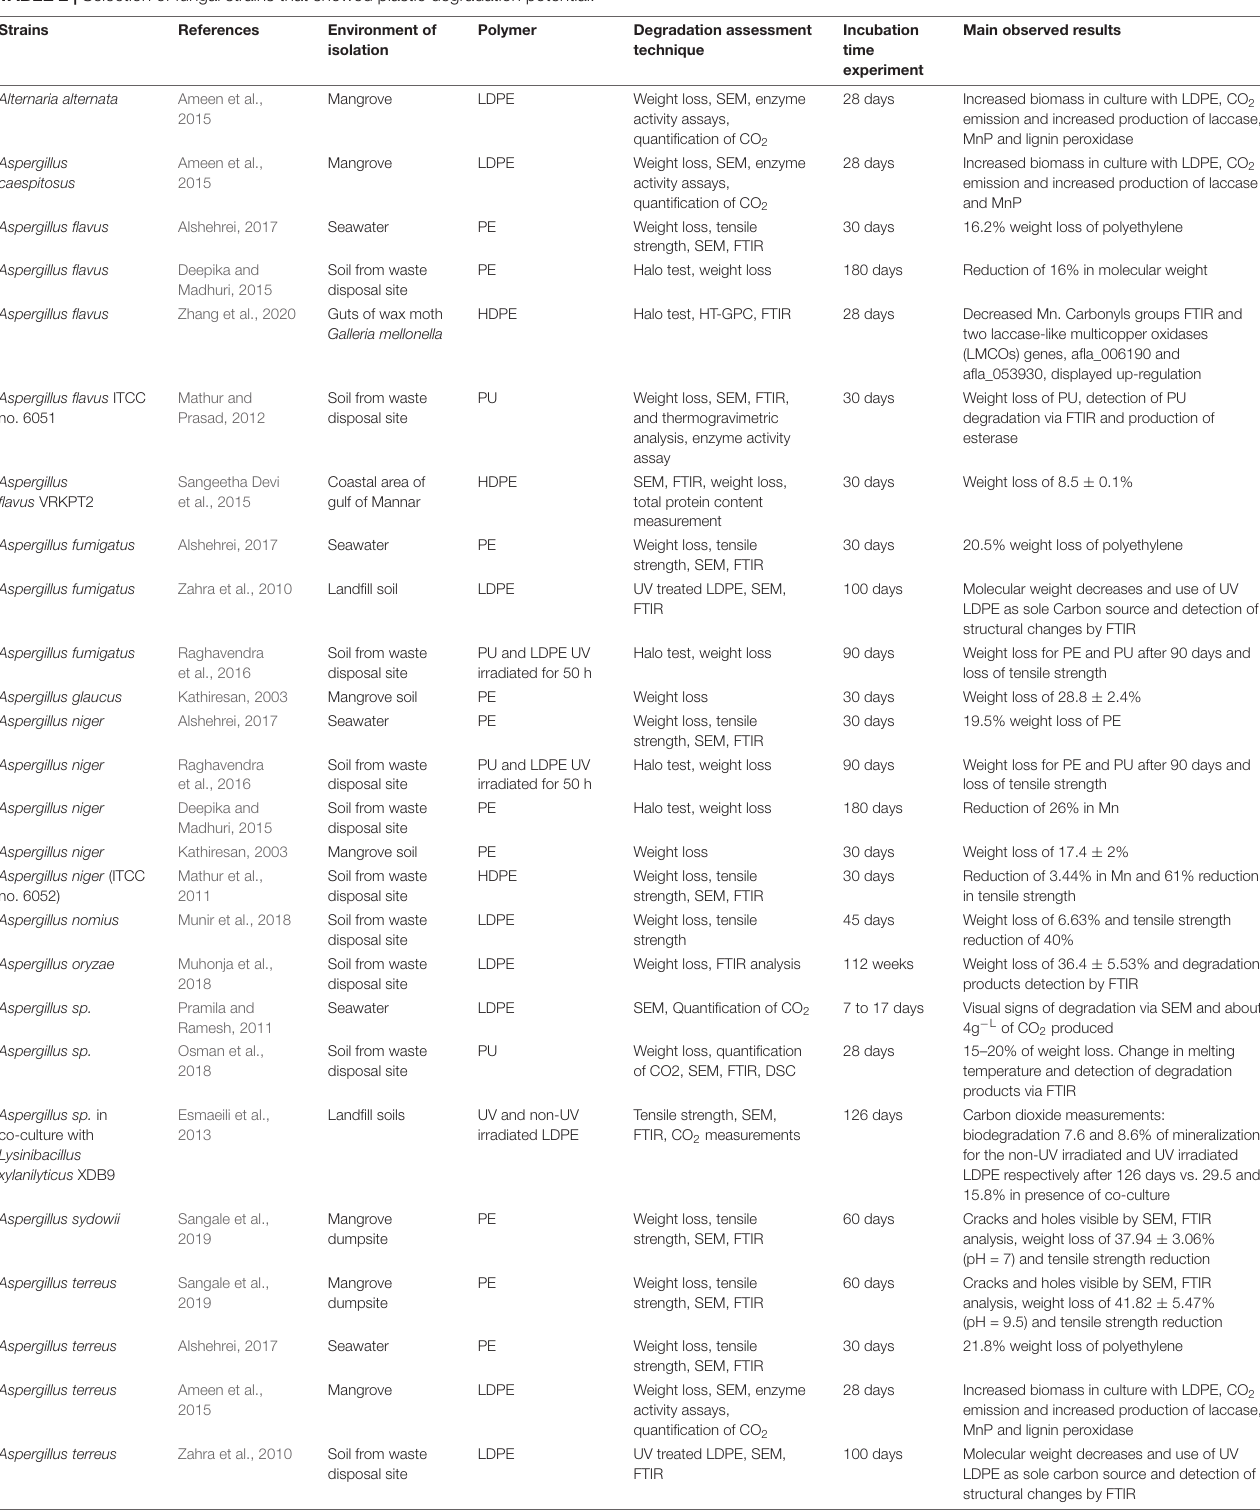
TABLE 2 | Selection of fungal strains that showed plastic degradation